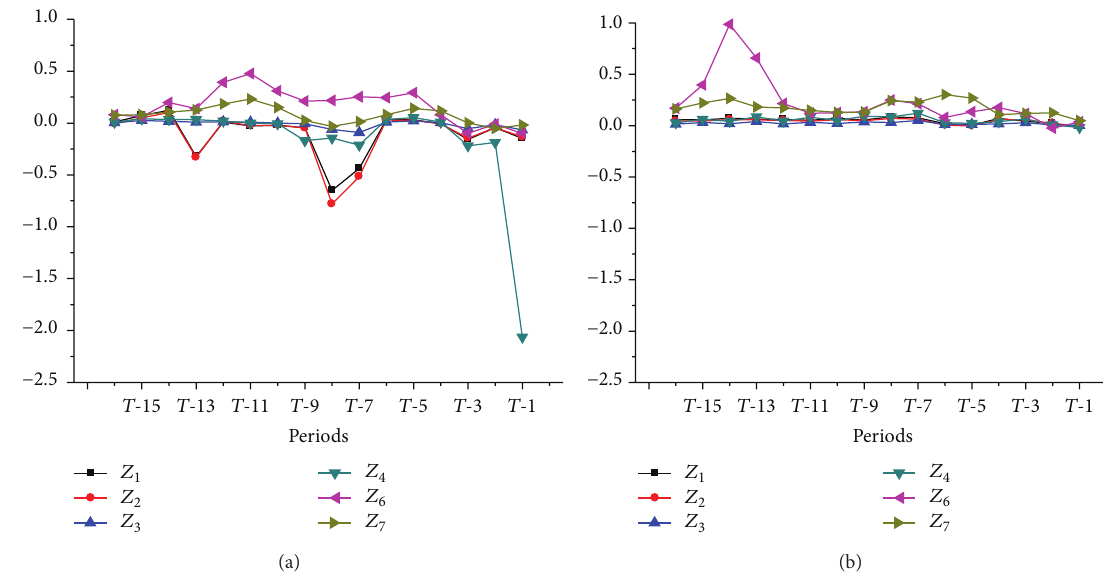
Figure 3: The trend analysis of mean of signal indicators of profitability for distress samples and healthy samples.